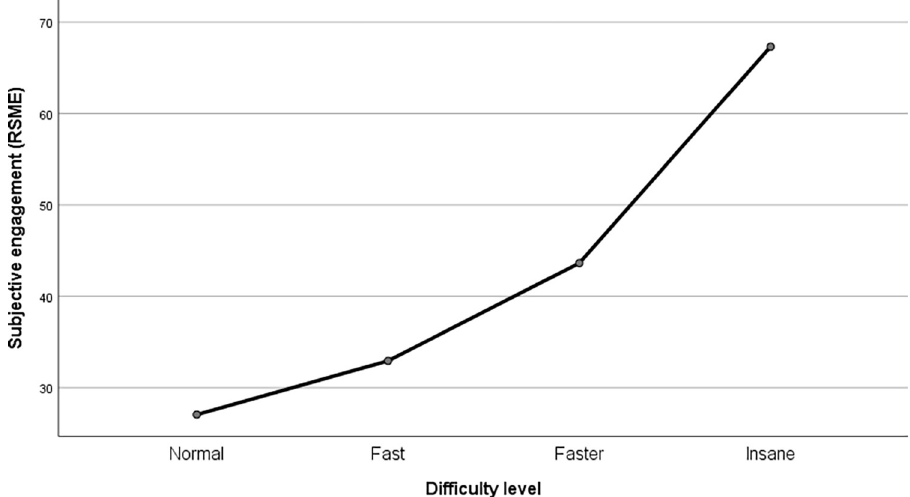
Fig 3. Subjective assessment in the game depending on the level of difficulty–results for Rating Scale Mental Effort.